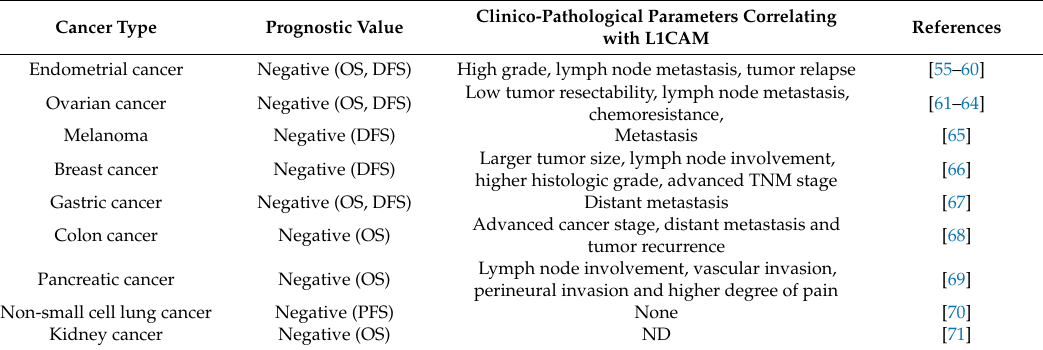
Table 2. L1CAM clinical relevance in